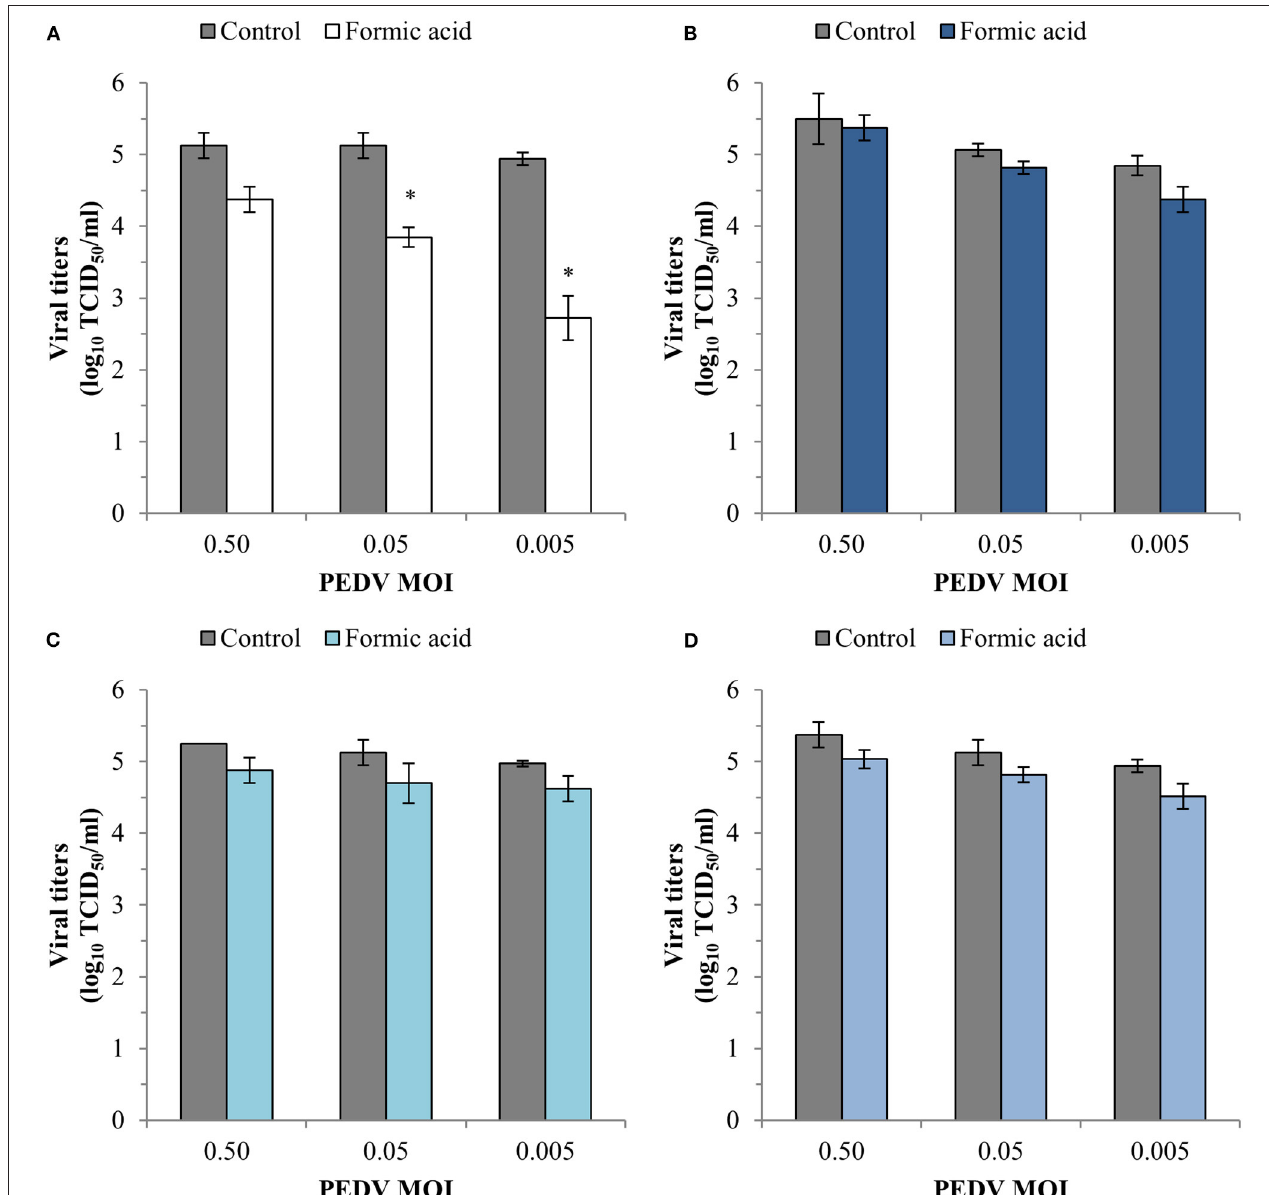
FIGURE 5 | Effect of a treatment with 1,200 ppm of formic acid on the different steps of the infection cycle of PEDV: replication (A) , viral inactivation (B) , attachment (C) and entry (D) . Data are expressed as mean ± standard deviations of viral titer expressed as log 10 TCID 50 /ml estimated using an infectivity assay following the Reed and Muench method. *Statistically significant differences with regard to controls ( p <